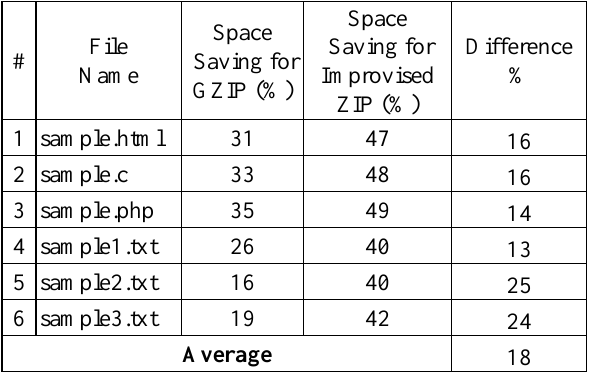
Table 6. Comparison of Space Savings for real-time